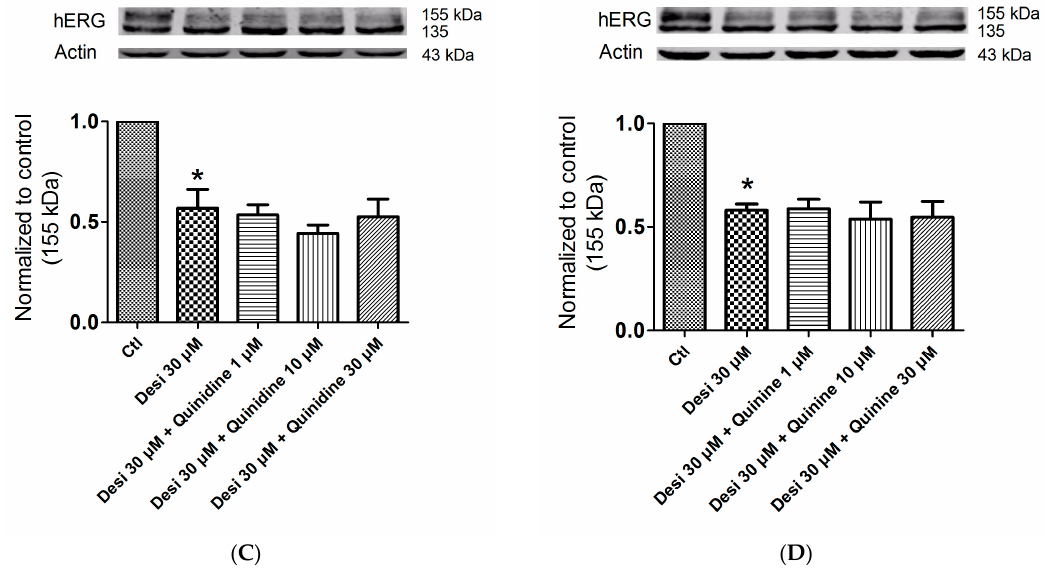
Figure 6. Effects of quinidine and quinine on the pentamidine- or desipramine-induced hERG defect. ( A ) Different concentrations of quinidine (1, 10, and 30 µ M) did not upregulate the expression of 155-kDa hERG after 30 µ M pentamidine treatment. * p < 0.05 vs. control, n = 3; ( B ) Different concentrations of quinine (1, 10, and 30 µ M) did not upregulate the expression of 155-kDa hERG after 30 µ M pentamidine treatment. * p < 0.05 vs. control, n = 3; ( C ) Different concentrations of quinidine (1, 10, and 30 µ M) did not upregulate the expression of 155-kDa hERG after 30 µ M desipramine treatment. * p < 0.05 vs. control, n = 3; ( D ) Different concentrations of quinine (1, 10, and 30 µ M) did not upregulate the expression of 155-kDa hERG after 30 µ M desipramine treatment. * p < 0.05 vs. control, n = 3 The hERG-HEK cells were incubated with the drugs for 24 h. Abbreviation: ctl, control.